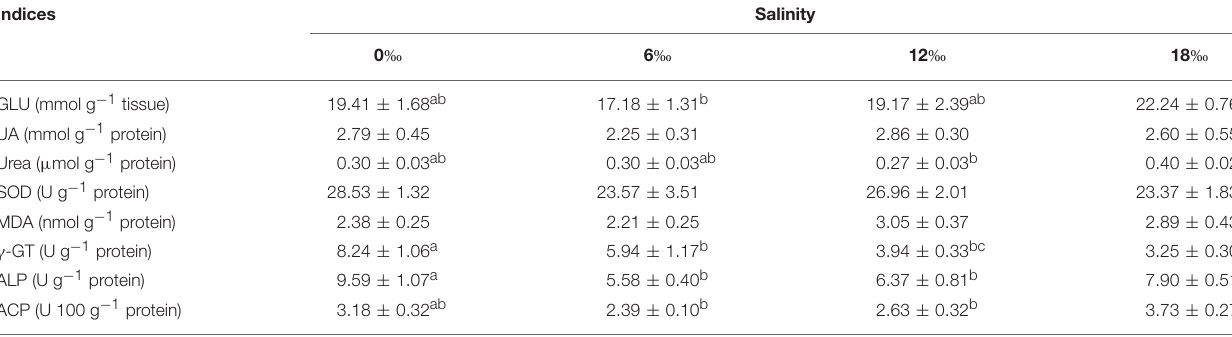
TABLE 6 | Hepatopancreas metabolism indices of female E. sinensis subjected to different salinities for 40 days.